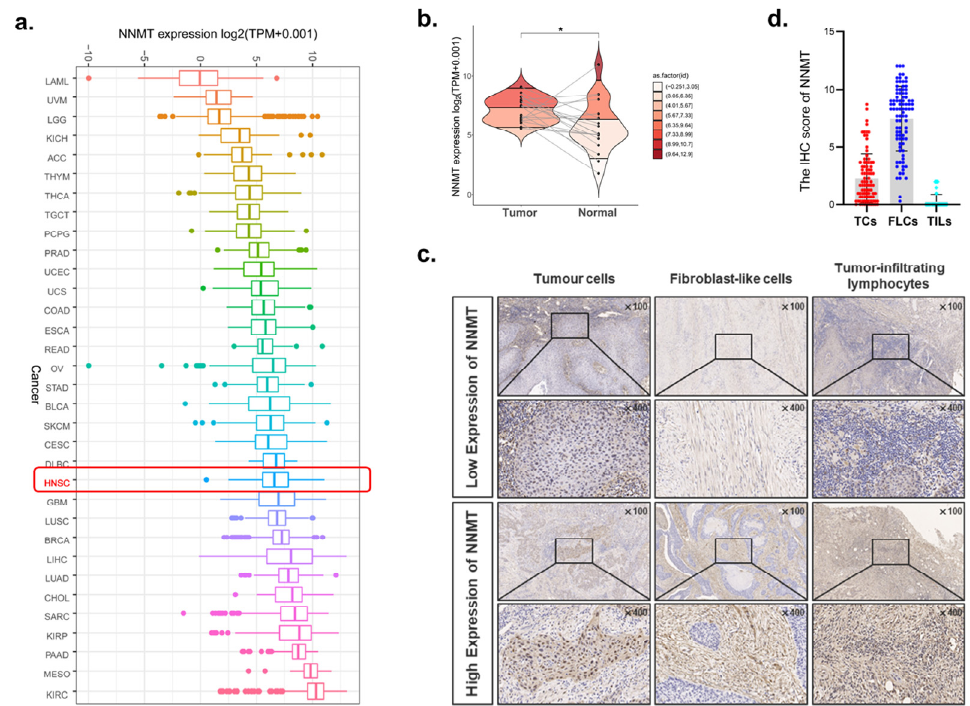
Figure 2. Expression of NNMT in OSCC and other cancers. ( a ) The NNMT expression in different tumor types using TCGA database. ( b ) RNA-seq data from TCGA study showed upregulation of NNMT in OSCC as compared with adjacent normal tissues (paired and unpaired samples, n = 19). ( c ) Typical IHC staining of NNMT high and low expression in TCs, FLCs and TILs, n = 90. ( d ) The IHC score of NNMT in TCs, FLCs and TILs from OSCC patients, n = 90. TCs, tumor cells; FLCs, fibroblast-like cells; TILs, tumor-infiltrating lymphocytes. * represents that differences were consid- ered statistically significant with p < 0.05. Table 1. Correlation between clinicopathology of OSCC patients and NNMT expression in TCs.